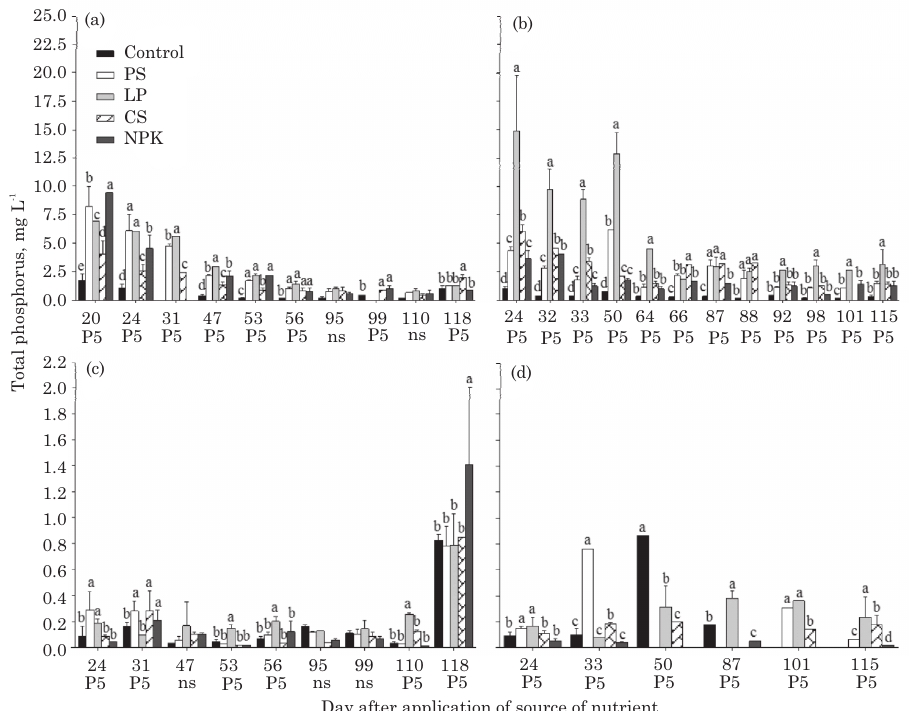
Figure 5. Total phosphorus content in the runoff solution on the soil surface from black oat (a) and maize (b); and in the leached solution from black oat (c) and maize (d), in a Typic Hapludalf treated with nutrient sources. P5: significant at 5 % probability by the Scott-Knott test; ns: not significant at 5 %